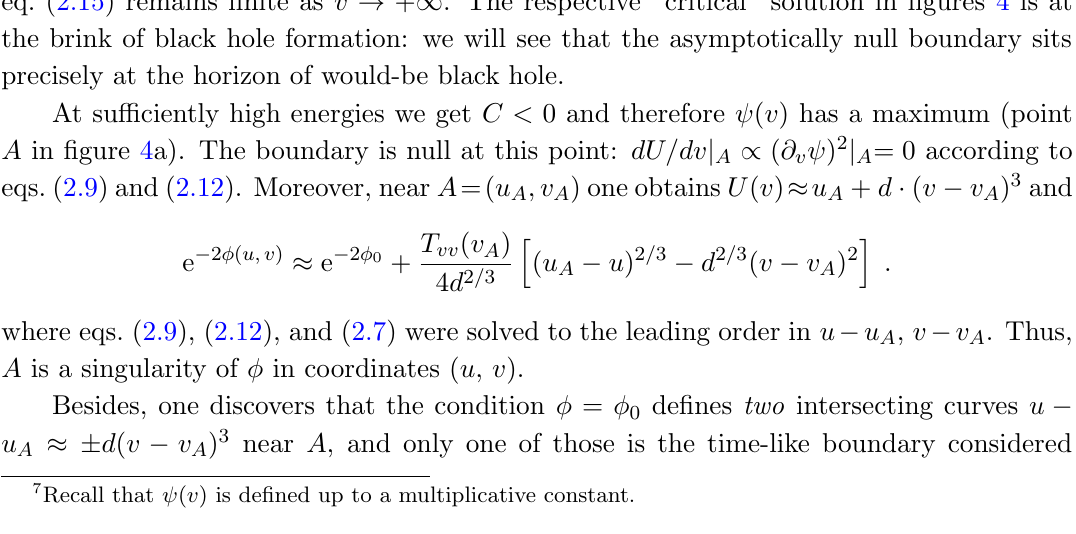
Figure 4 . Functions ( v ) and U ( v ) at di(cid:11)erent T vv . The right graph is rotated for visualization purposes. Dashed line in this graph is the space-like \singularity" (cid:30) = (cid:30) 0